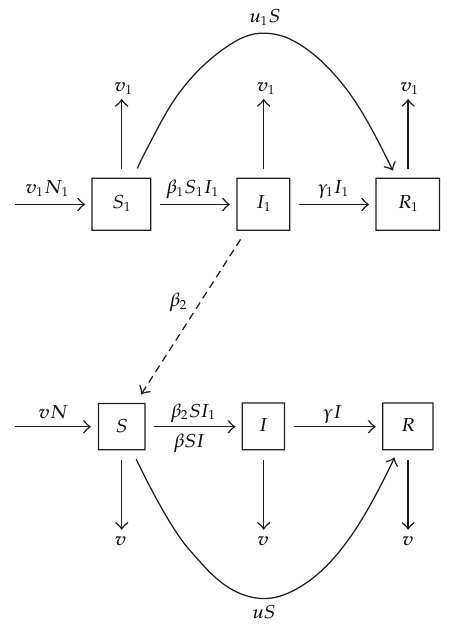
Figure 1: Flow chart of two interacting